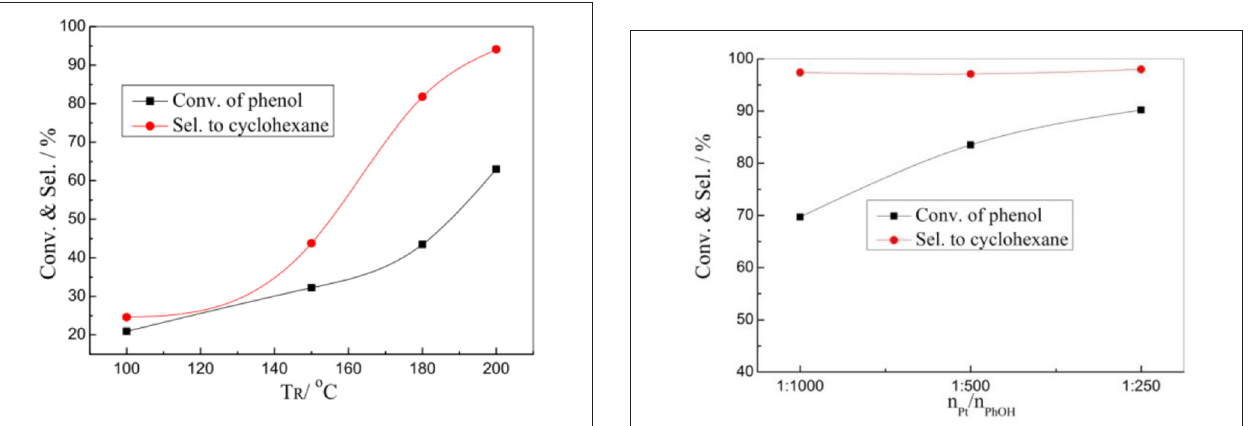
FIGURE 5 | Effect of T R on the HDO of phenol over 1%Pt/SBA-Pr. Reaction conditions: P H2 , 3.00 MPa; 800 rpm; t R , 4h, 0.0250mol PhOH in 50.0mL CH